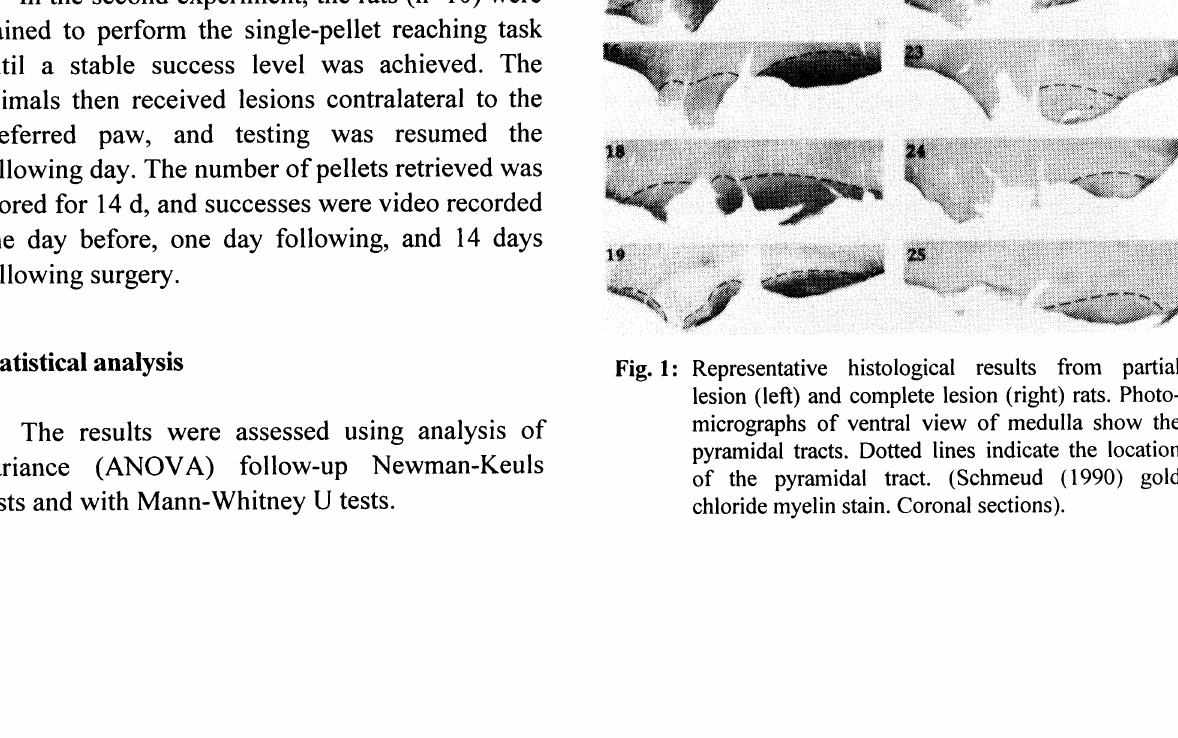
Fig. 1: Representative histological results from partial lesion (left) and complete lesion (right) rats. Photo- micrographs of ventral view of medulla show the pyramidal tracts. Dotted lines indicate the location of the pyramidal tract. (Schmeud (1990) gold chloride myelin stain. Coronal